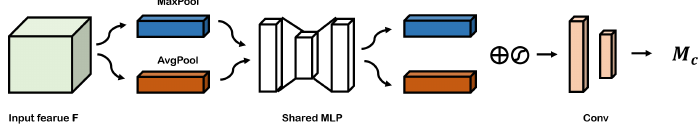
Figure 9. The details of